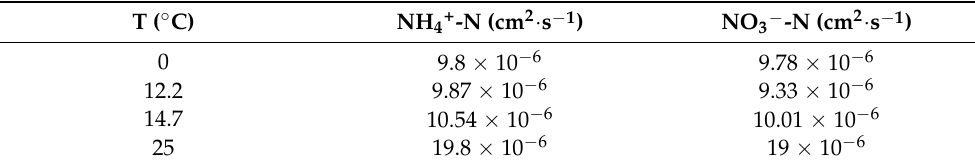
Table 3. The actual diffusion coefficient under different T conditions of NH 4+ -N and NO 3- -N.